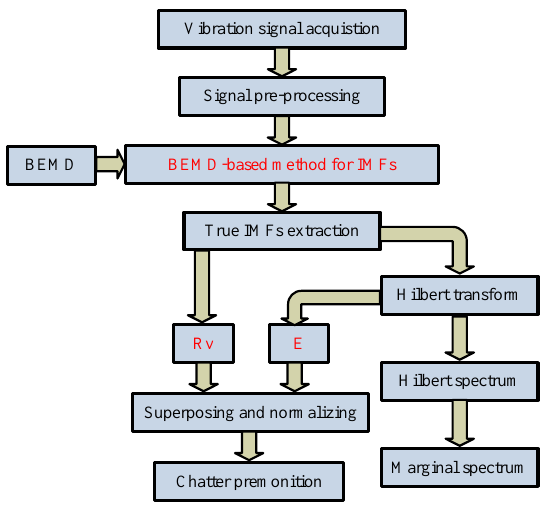
Figure 1. The process of extracting feature vectors from grinding chatter signals.